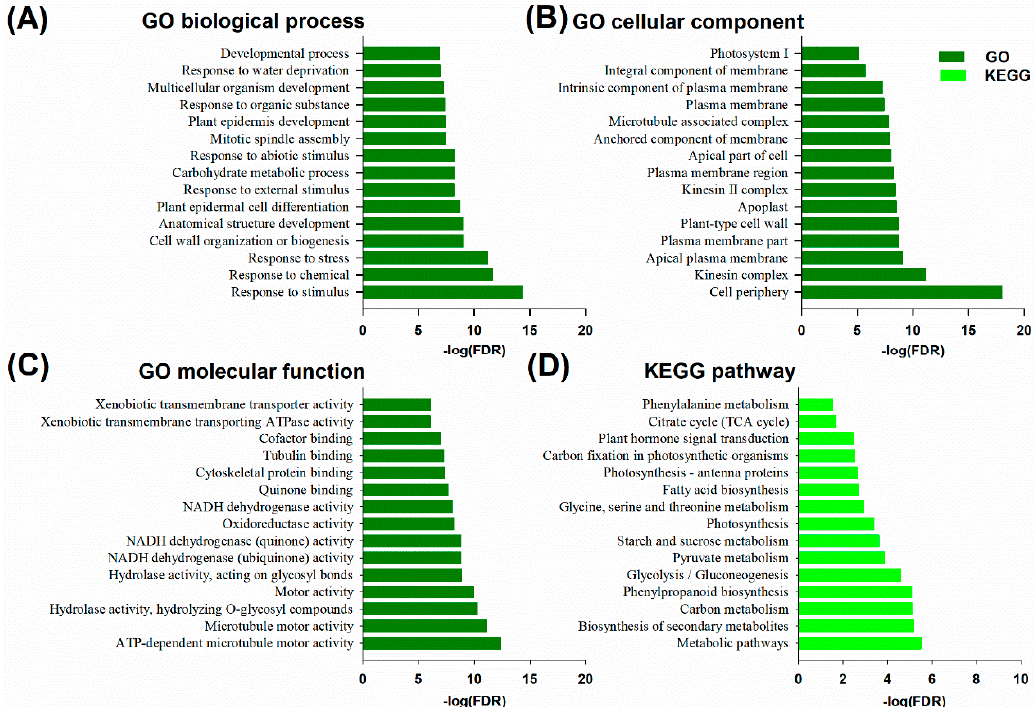
Figure 7. The Gene Ontology (GO) terms and Kyoto Encyclopedia of Genes and Genomes (KEGG) pathway enrichment of differentially expressed mRNAs (DEMs) in the leaves of trifoliate orange subjected to boron deficiency stress. GO stands for gene ontology; FDR for false discovery rate; KEGG, the Kyoto encyclopedia of genes and genomes. ( A ) Biological process of GO terms. ( B ) Cellular component of GO terms. ( C ) Molecular function of GO terms. ( D ) KEGG pathways.